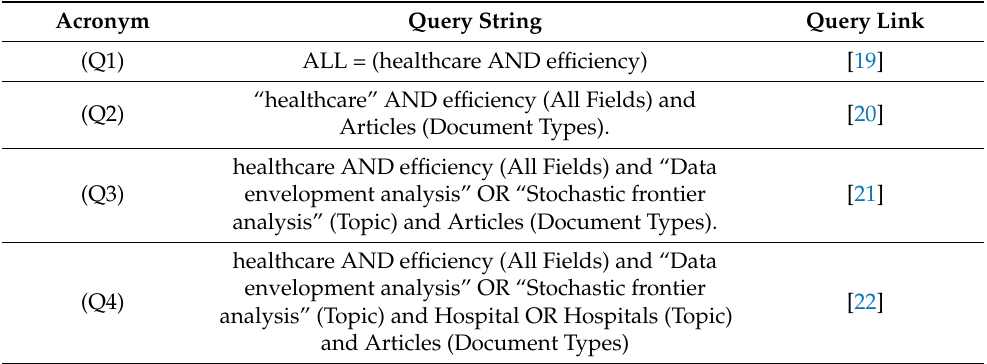
Table 1. Strings used in the Web of Science systematic